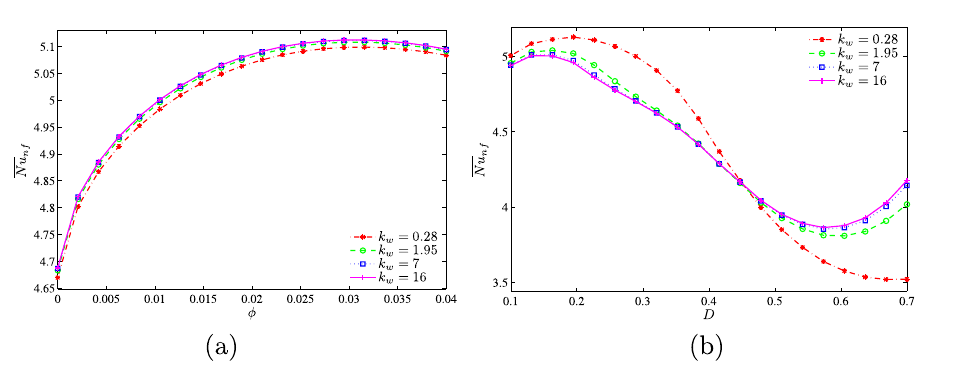
Figure 17. Variation of local Nusselt number interfaces with ( a ) Y and ( b ) X for different k w at Ra = 10 5 , φ = 0.02, Ha = 15 and D = 0.3.